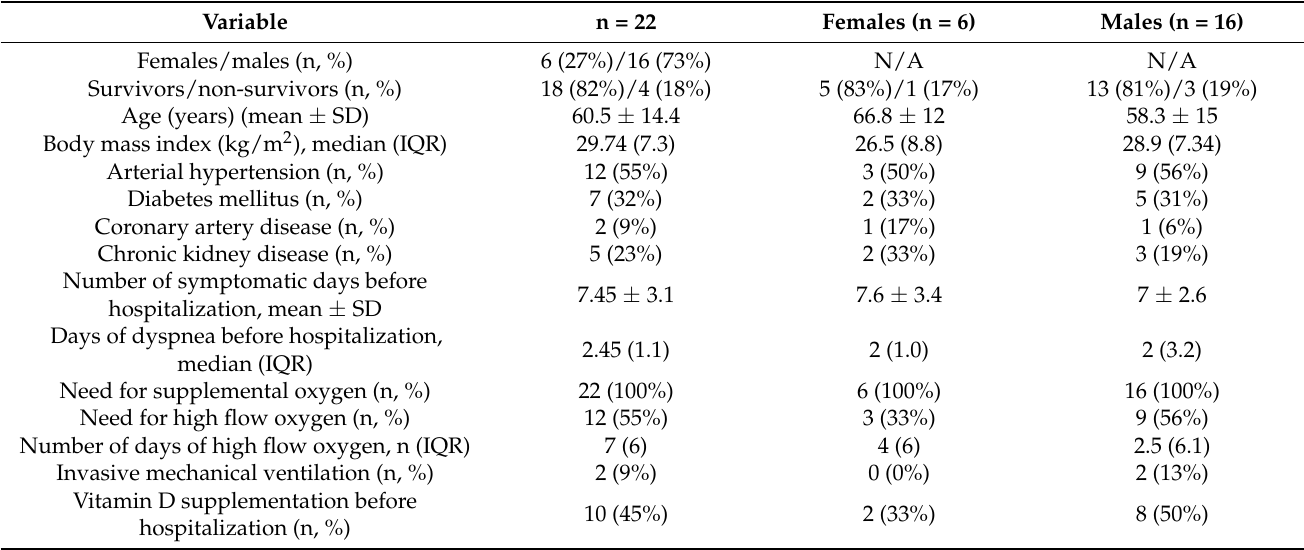
Table 1. Baseline characteristics of